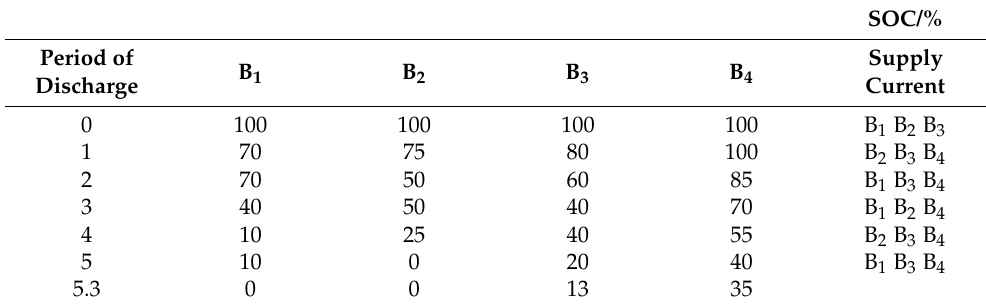
Table 2. Dynamic redundant battery management algorithm discharge process.